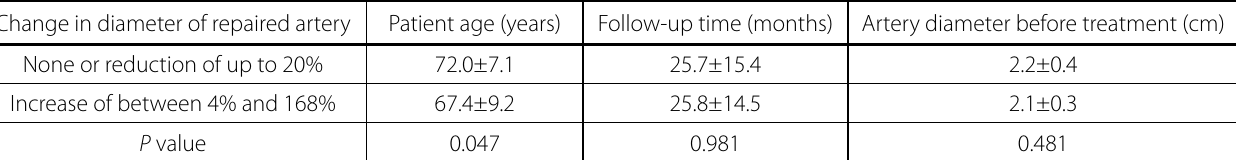
Table 4. Means and standard deviations for patient age, follow-up time, and artery diameter before treatment, in cases with dilation of repaired artery on last CT